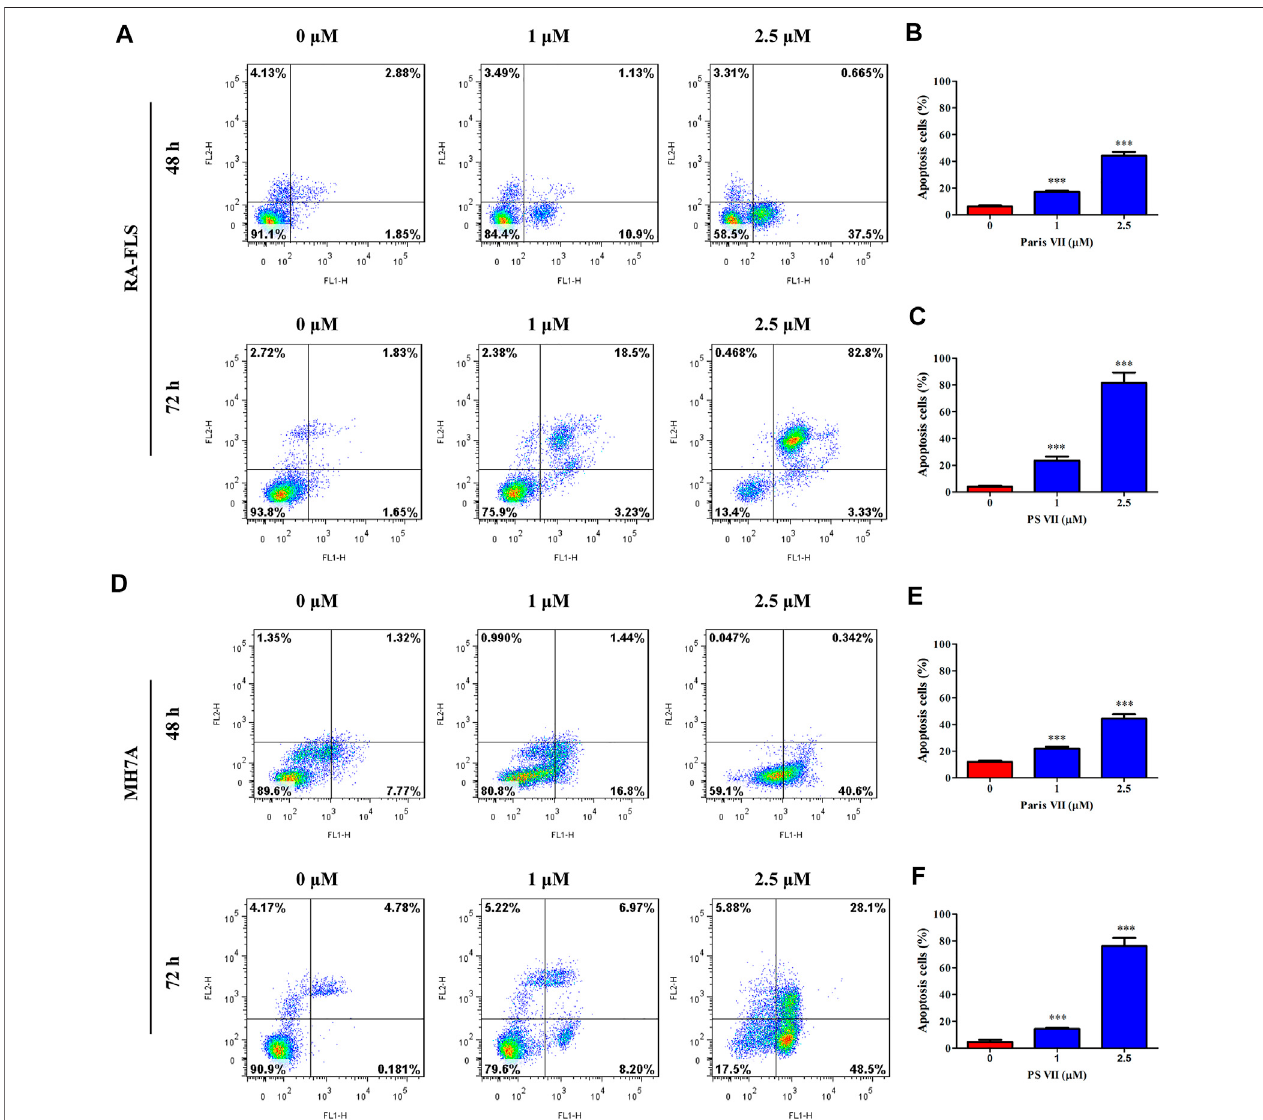
FIGURE4| Effects ofPSVII onapoptosisinRA-FLS and MH7Acells.RA-FLS andMH7Awastreated withdifferent concentrationsofPSVII (0,1,2.5 μ M) for48 h, and 72 h. The apoptosis was determined by fl ow cytometry. (A) The apoptosis of RA-FLS with PS VII treatment for 48 h (A, upper panel) and 72 h (A, lower panel). The populations of apoptotic cells were evaluated as the percentage of total cells for 48 h (B) , and 72 h (C) . (D) The apoptosis of RA-FLS with PS VII treatment for 48 h (A, upper panel) and 72 h (A, lower panel). The populations of apoptotic cells were evaluated as the percentage of total cells for 48 h (E) , and 72 h (F) . Each bar represents the mean ± SD of three independent experiments. Compared with the control group, * p < 0.05, ** p < 0.01, *** p < 0.001.